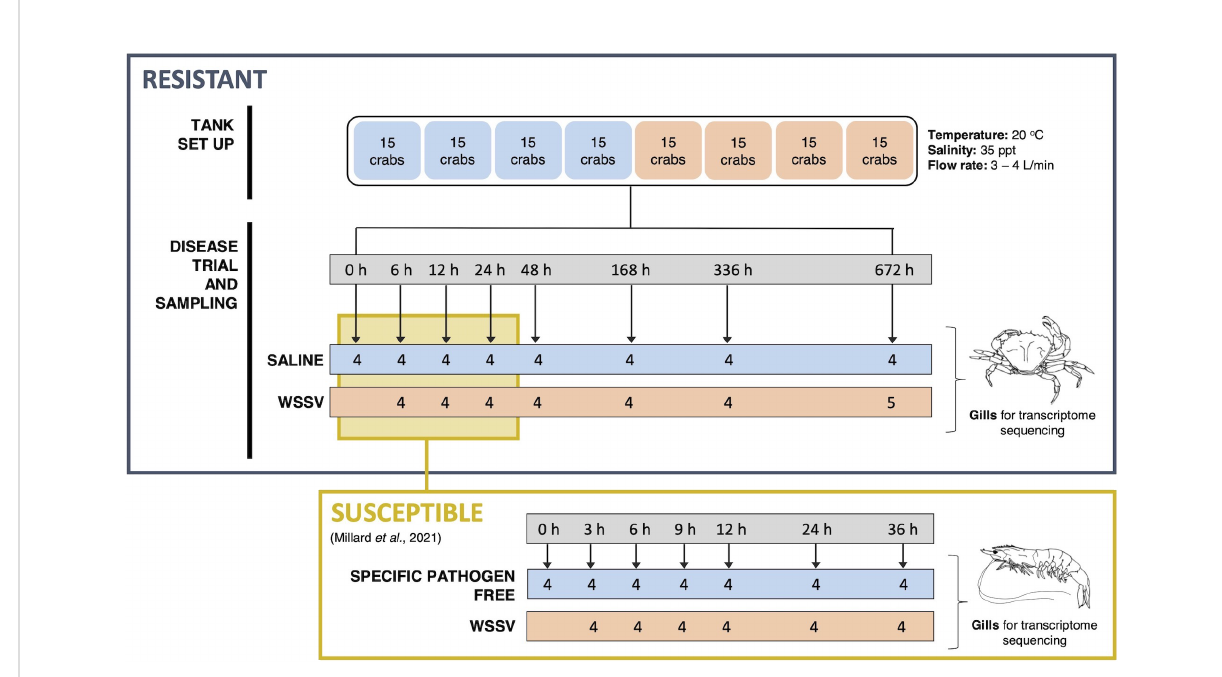
FIGURE 1 Schematic of the WSSV exposure and sampling procedure for both resistant and susceptible crustaceans. The upper panel outlines the experimental WSSV injection trial performed to generate RNA-seq and miRNA-seq datasets for resistant crab ( C. maenas ). Crabs were randomly allocated into two groups and housed in individual compartments in tanks. These groups were injected with either saline solution or WSSV- infected shrimp homogenate for the disease trial and the gills of 8 crabs were sampled from saline and WSSV-injected treatment groups at 0, 6, 12, 24, 48, 168, 336 and 672 hours and snap frozen for transcriptome sequencing. The lower panel illustrates the equivalent time course experiment in the susceptible shrimp ( P. vannamei ) reported in a previously published WSSV-exposure dataset utilised for comparison